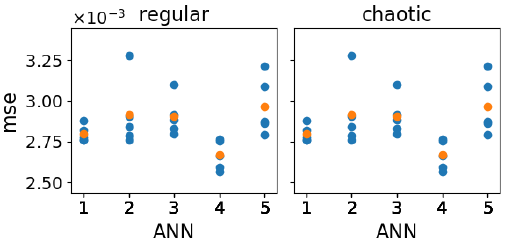
Figure 3. Loss function value for w mass = 0 (MSE) of the valida- tion data corresponding to the last five epochs of the training process (blue) for each trained ANN ( x axis). For each ANN, the mean loss function value over the last five epochs is depicted in